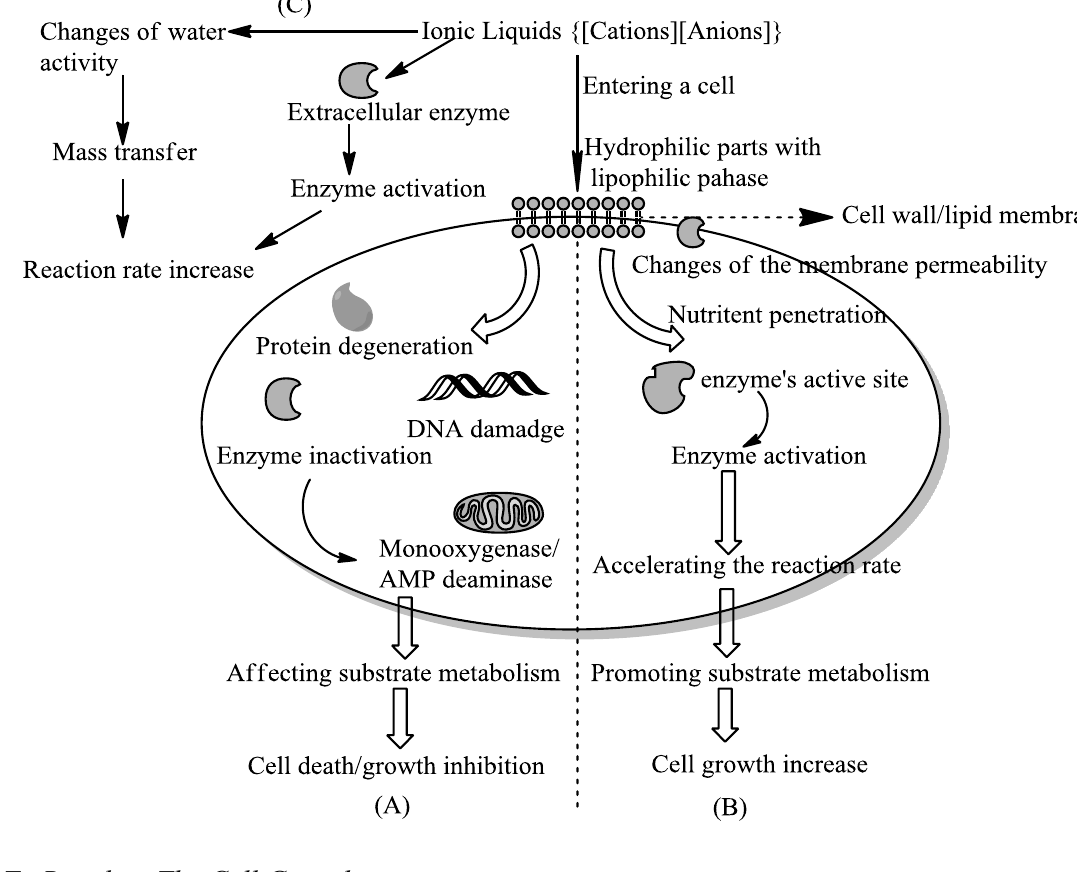
Figure 3. Possible interaction mechanisms of ionic liquids with cells in whole-cell biotransformation. ( A ) Some ILs may affect the cell microstructure and lead to cell growth inhibition or cell death; ( B ) The pathway describes an increase of cell growth in the presence of ILs; ( C ) Some ILs may accelerate the mass transfer and reaction